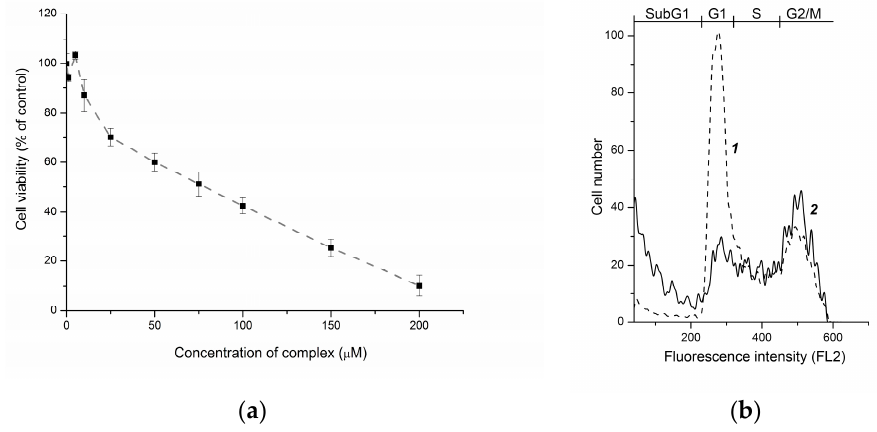
Figure 3. Cell viability inhibition ( a ) and cell cycle changes ( b ) caused by ETM in A172 cells after 24 h exposure. A, the dose-effect curve. B, the histograms of propidium iodide DNA staining in the untreated (1) and ETM-treated cells (2); on the top, the cell cycle phases, as well as cell population with decreased DNA content (SubG1, dying cells) are marked. Table 2. Cell cycle distribution of A172 cells after treatment with ETM.